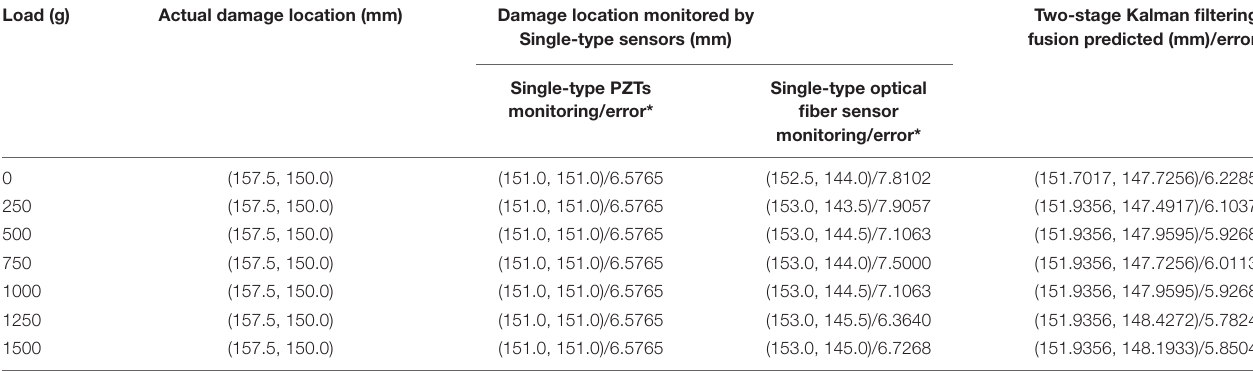
TABLE 4 | The predicted damage center location and location error of single-type sensors and two-stage Kalman filtering fusion. Load (g) Actual damage location (mm) Damage location monitored by Single-type sensors (mm)